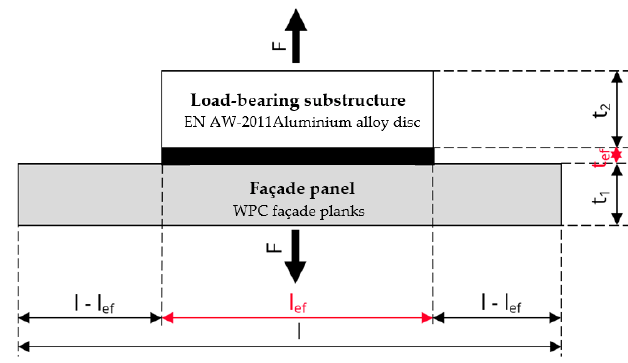
Figure 1. Single lap joint test sample geometry—cross section.